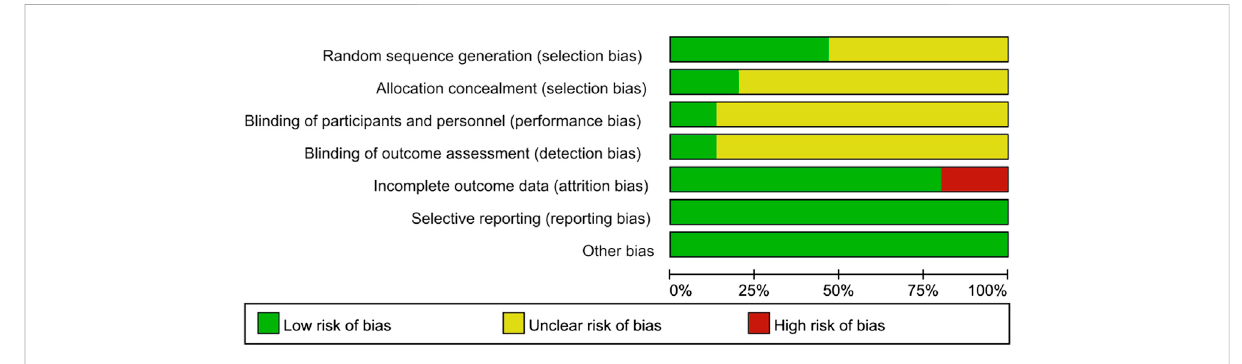
FIGURE 2 Risk of bias graph. The judgments of the reviewing authors abouteach domain ofbias are presented as percentages of all included studies. The quality of the selected studies was assessed according to the Cochrane